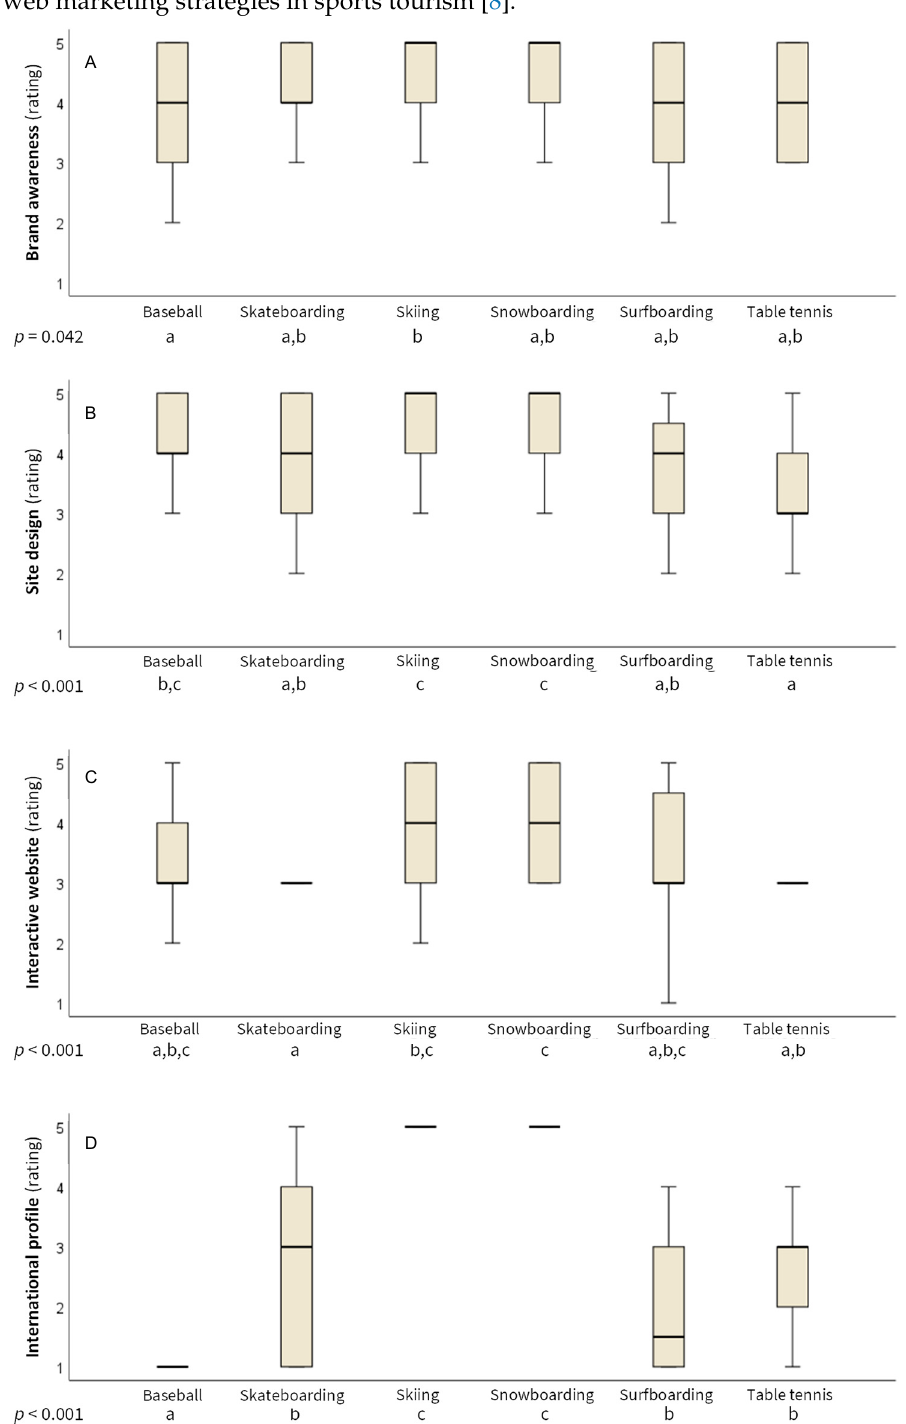
Figure 6. Results of the evaluation of the “Communication” dimension, and grouping (a–c) based on statistical analysis. The subfigures show the results of the various Sub-Dimensions, namely Brand awareness (A), Site design (B), Interactive website (C), and International profile (D).